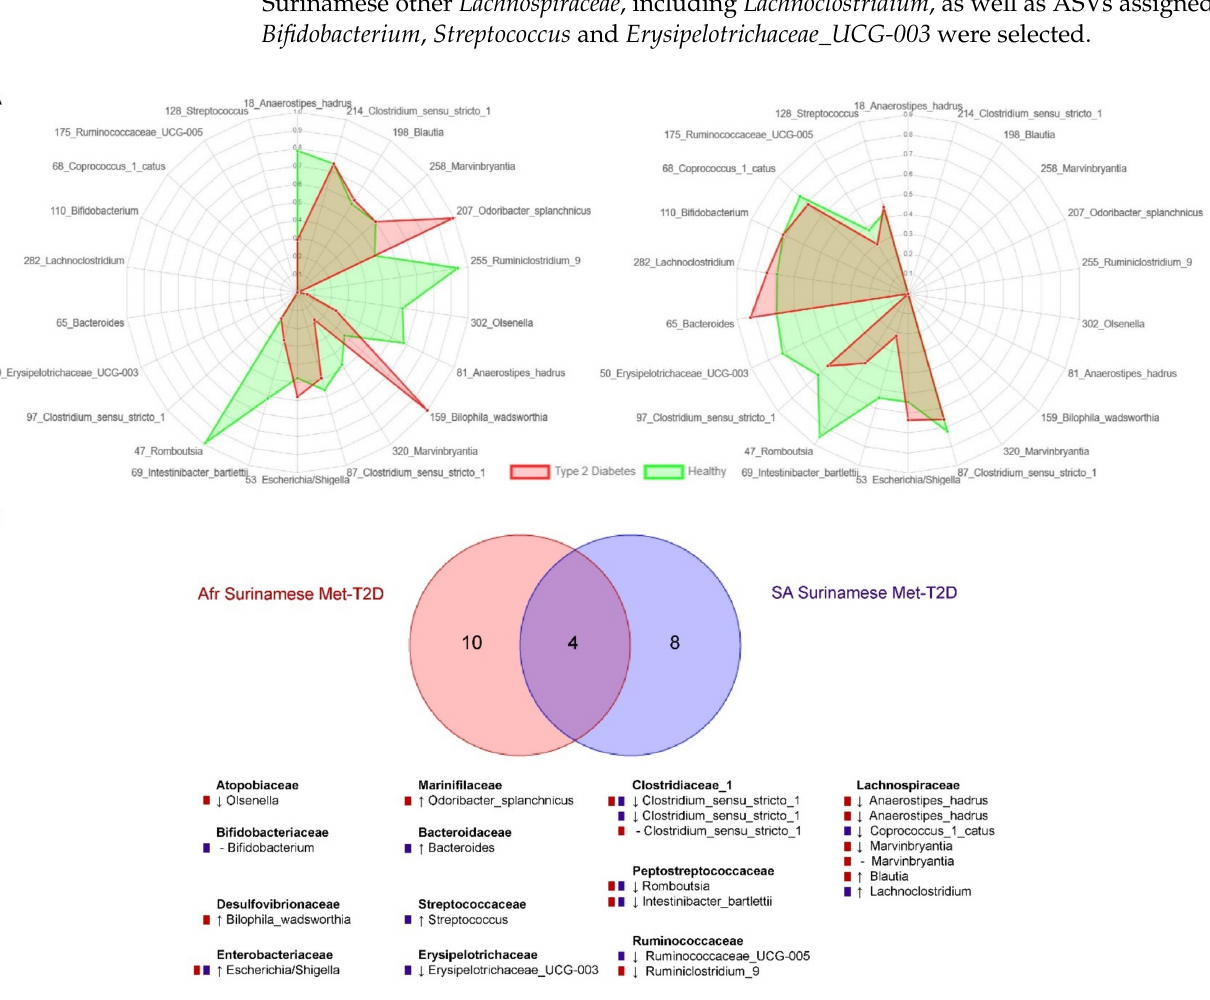
Figure 4. Overview of identified biomarkers in machine learning models for the African Surinamese Met-T2D dataset (Met-T2D cases and matched controls) and the South-Asian Surinamese Met-T2D dataset (Met-T2D cases and matched controls). ( A ): Abundance of identified biomarkers for the African Surinamese Met-T2D dataset (left) and the South-Asian Surinamese Met-T2D dataset (right). Biomarkers are indicated with (ASV nr)_(taxonomy). Values are scaled medians of zero mean unit variance scaled features. Only the features which were selected for the ethnic group under consideration are displayed. ( B ) Overlap in selected ASVs for classifying Met-T2D cases in the machine learning analysis across ethnicities. ASVs are indicated by taxonomy name. Duplicate taxonomy names indicate different ASVs. Color of box in front of the ASVs indicates the ethnicity for which the ASV was important. –equal median relative abundance of ASV between Met-T2D cases and matched healthy controls, ↓ lower median relative abundance of ASV in Met-T2D cases compared to matched healthy controls, ↑ higher median relative abundance of ASV in Met-T2D cases compared to matched healthy